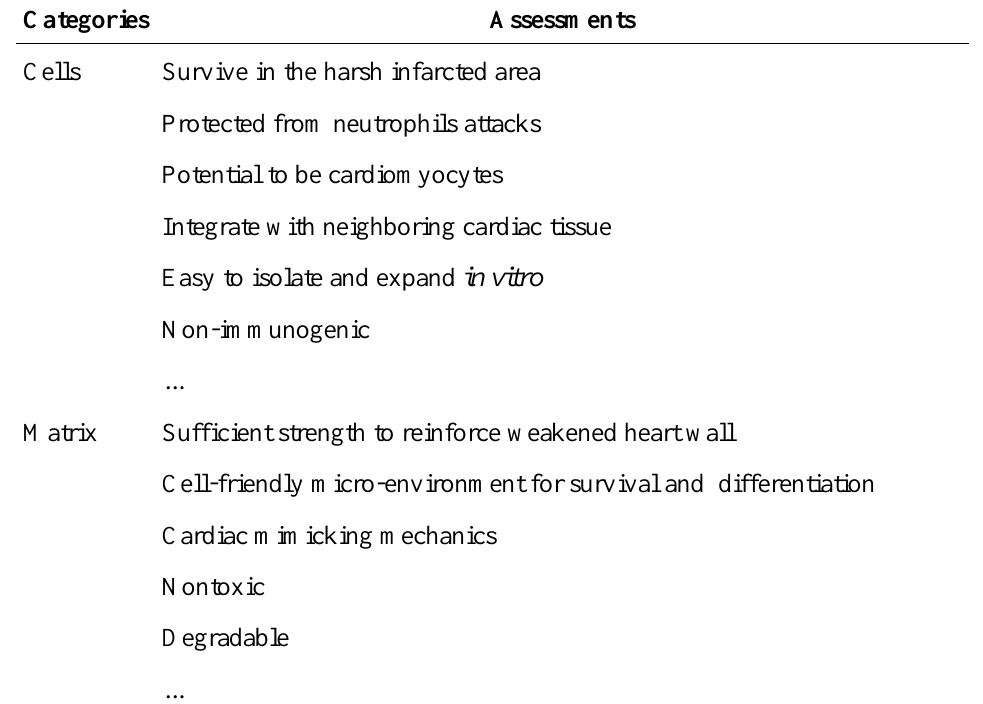
Table 1. Criteria for successful cardiac tissue engineering: the requirements for cells and supporting